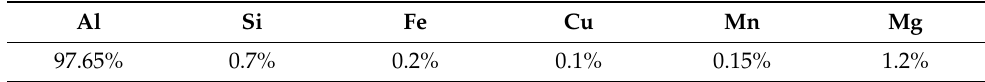
Table 1. Chemical composition of recycled aluminum alloys.